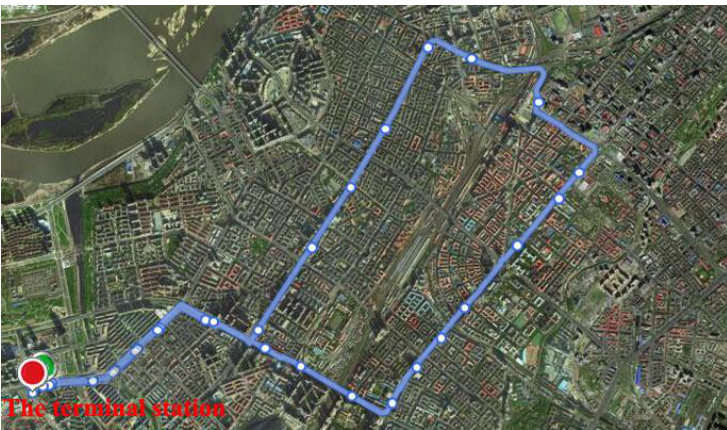
Figure 3. The route map of line 110 in Harbin. Table 2. Information used in the research among the bus GPS data (sample data).